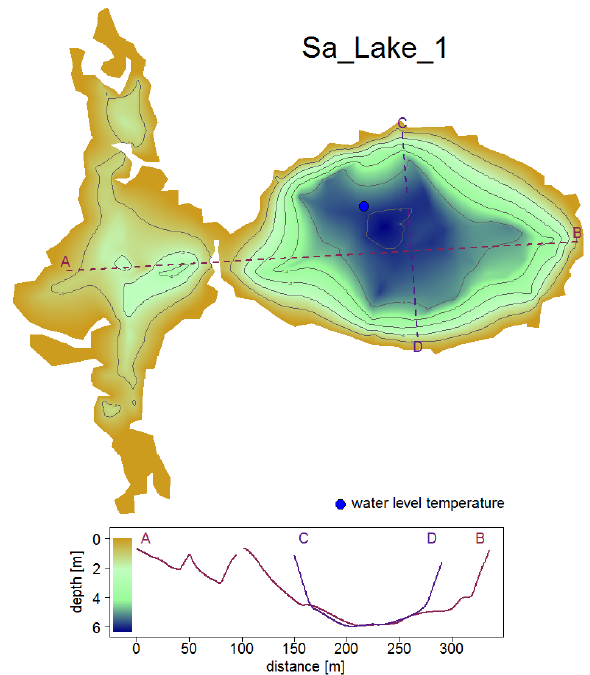
Figure A1. Bathymetry and cross sections of Sa_Lake_1 with loca- tion of sensors.